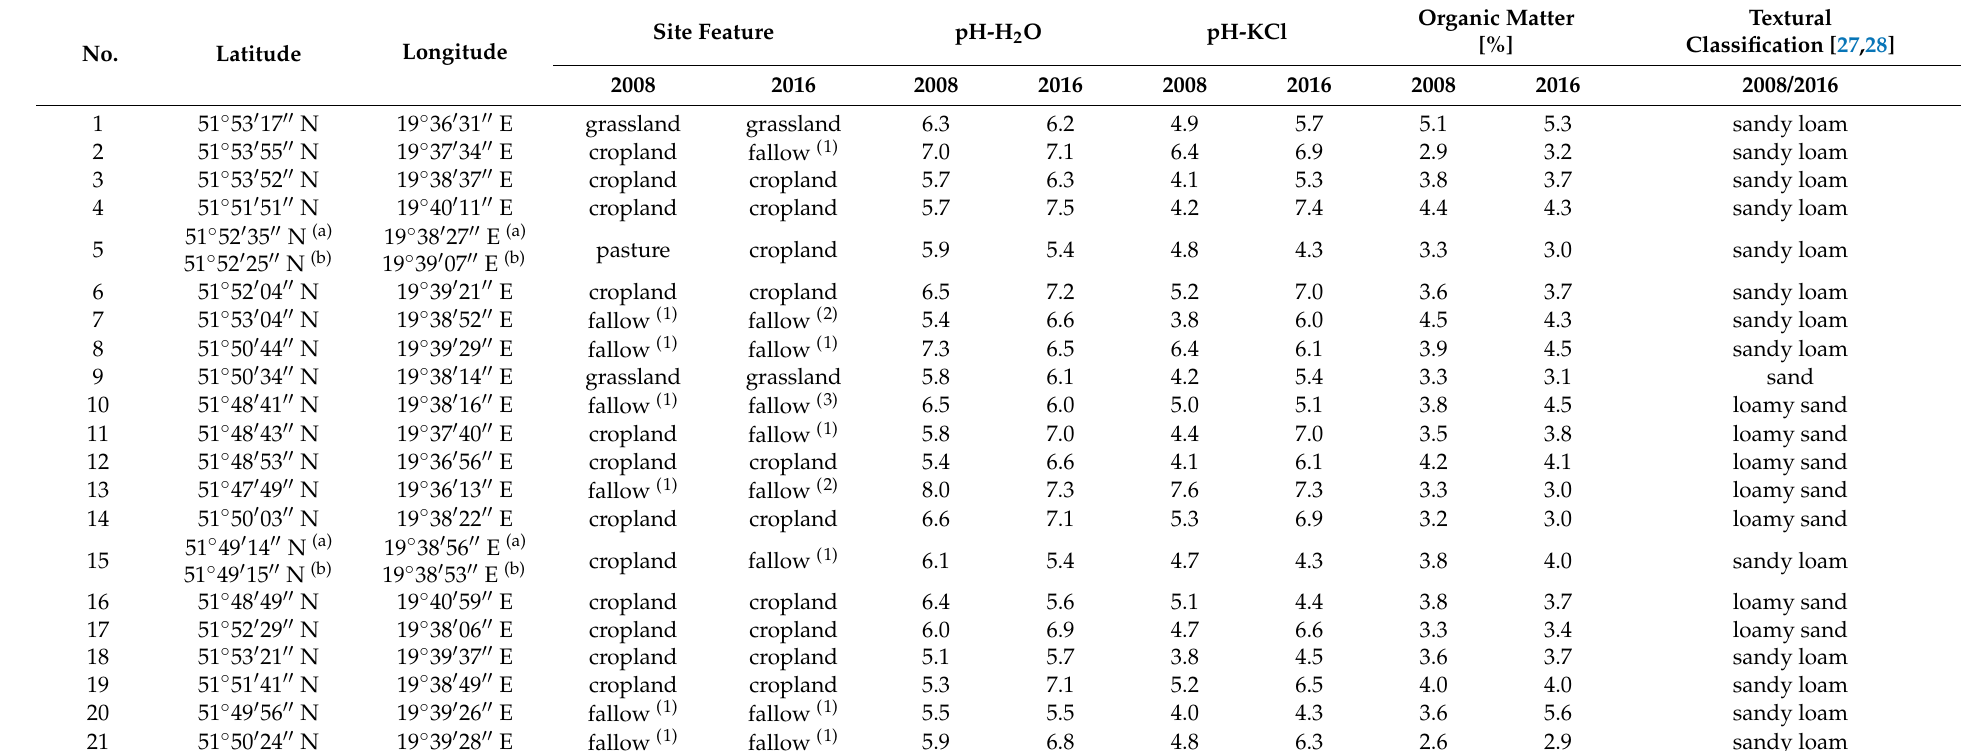
Table 1. Description of sampling